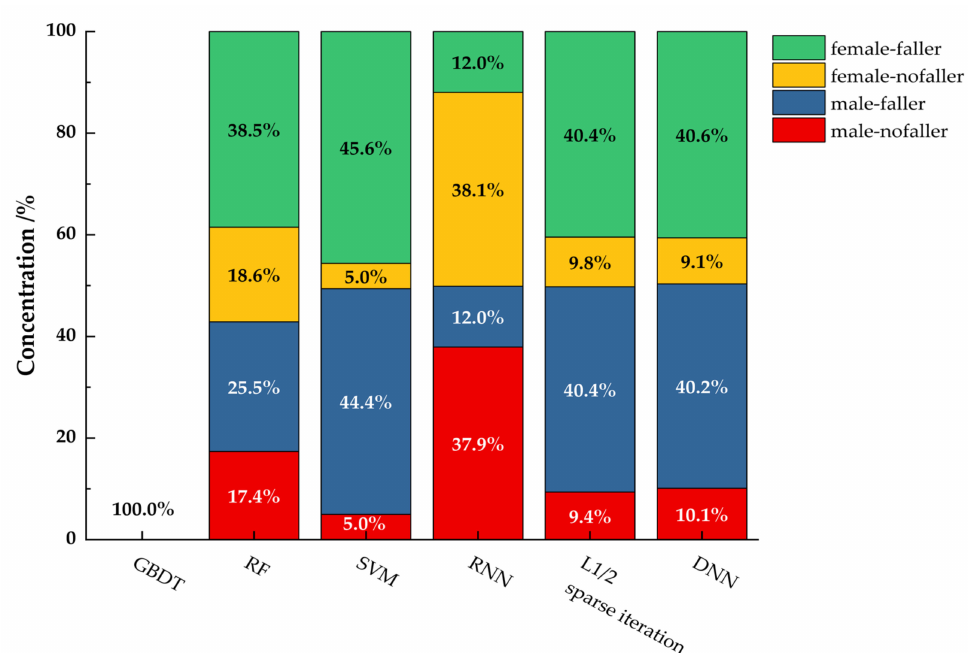
Figure 5. Prediction effects of machine learning algorithms in different groups (Note: All the RMSE of GBDT are